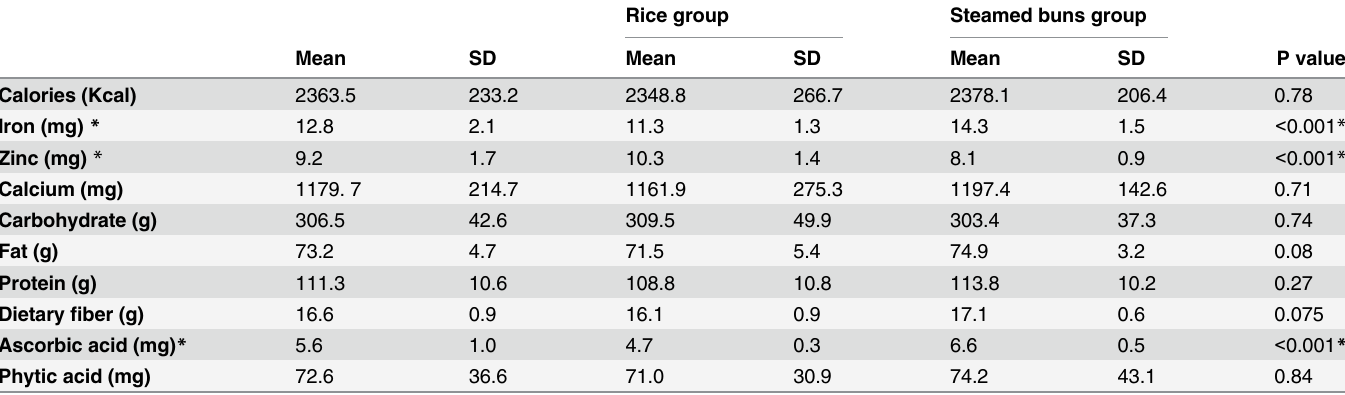
Table 4. Daily average intakes of major nutrients, and enhancers and inhibitors of iron